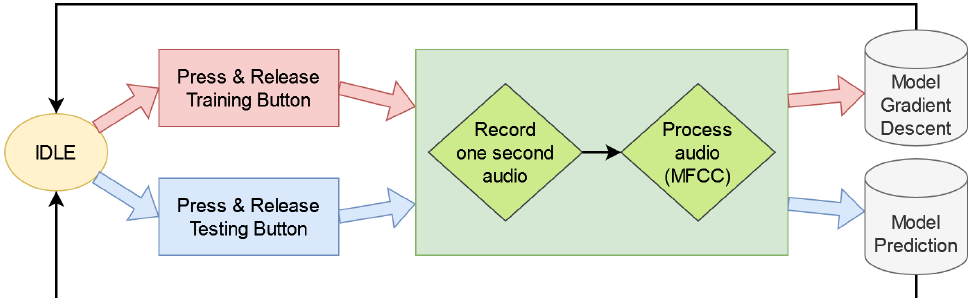
Figure 2. Workflow diagram for interactive on-device training of a single